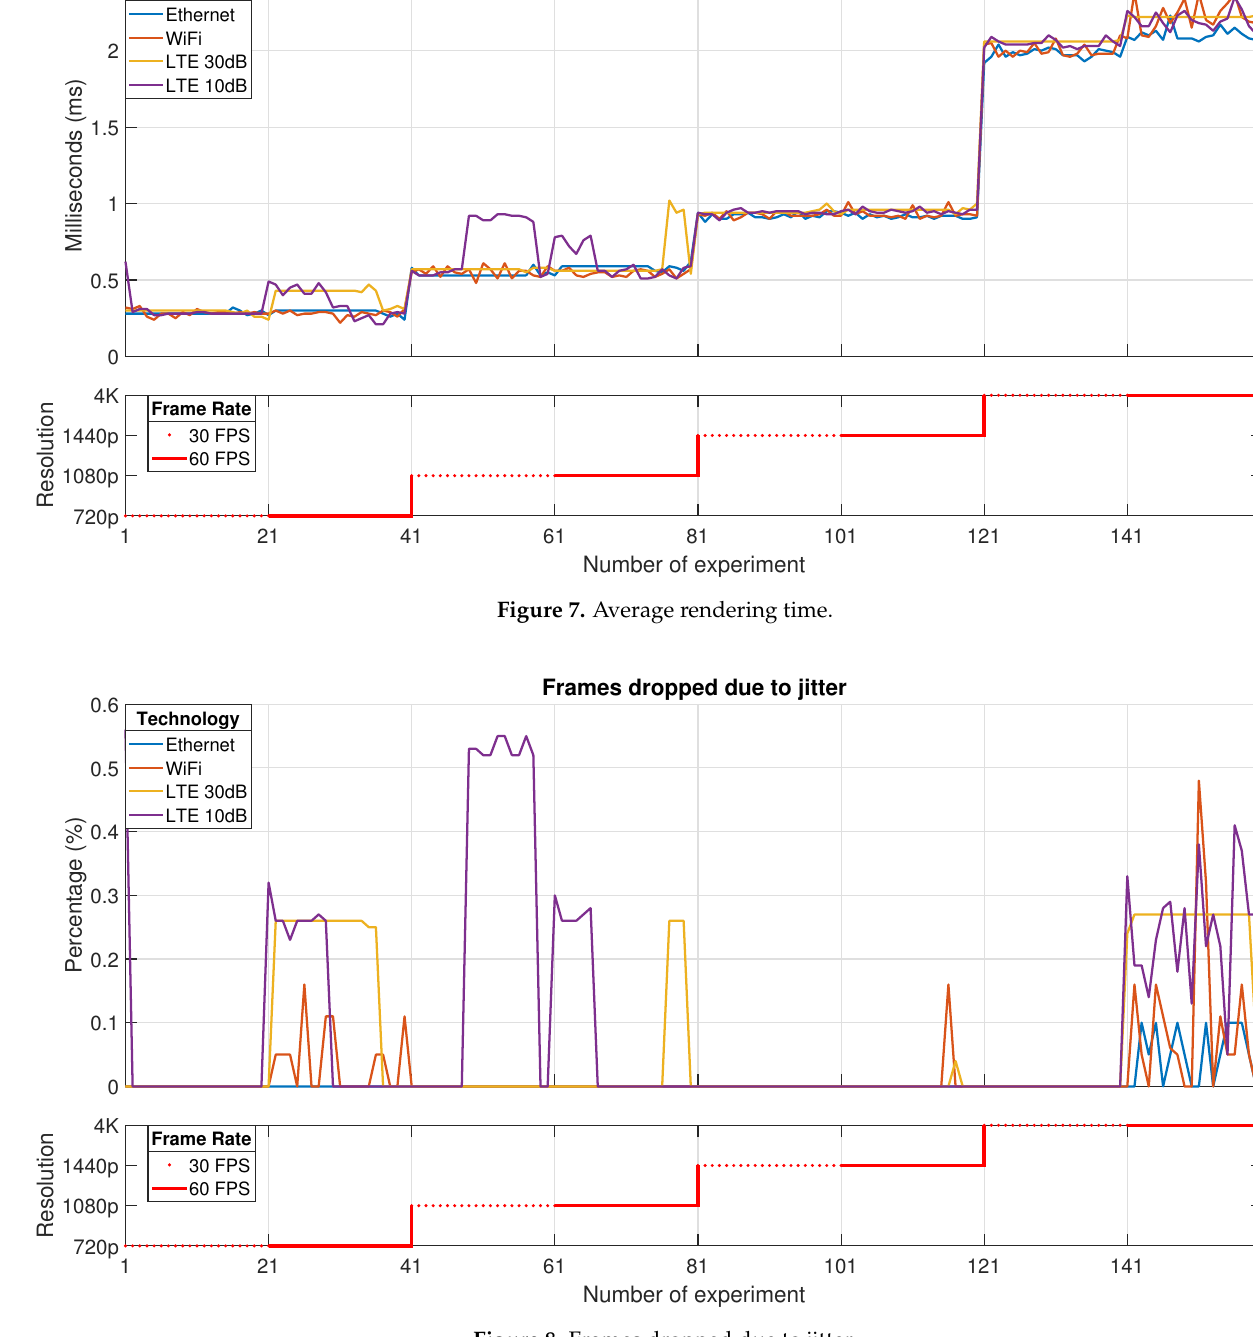
Figure 8. Frames dropped due to